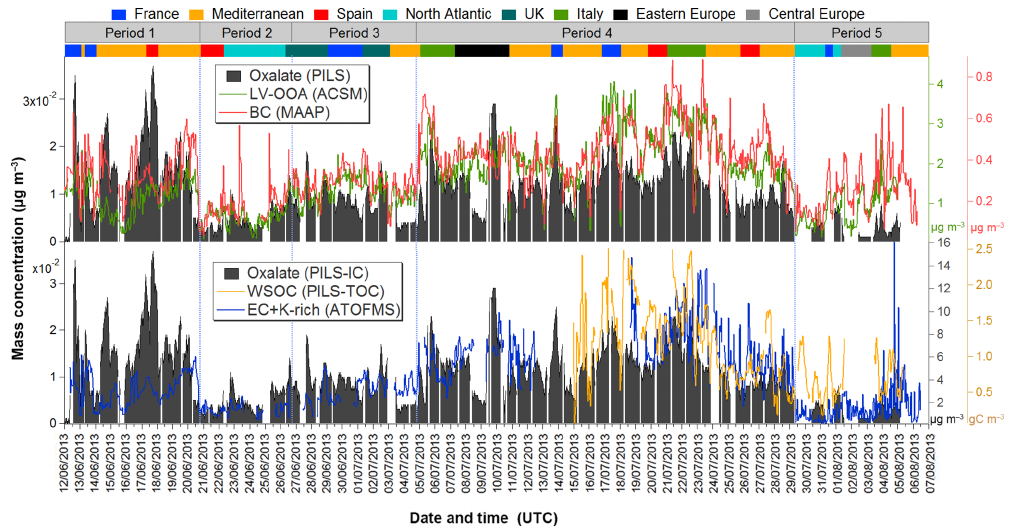
Figure 11. Hourly mass concentrations of the ACSM factor SV-OOA, BC (black carbon), WSOC (water soluble organic carbon) and ATOFMS EC + K-rich particles during ADRIMED and SAF-MED. Dates are